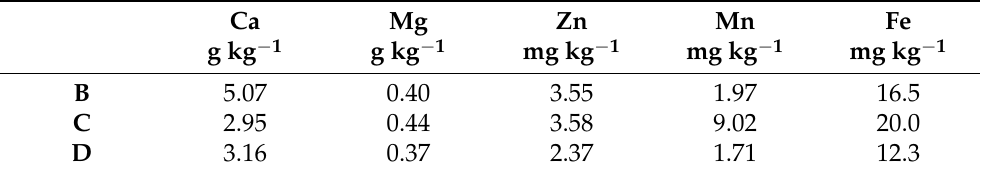
Table 5. Bioavailable content of Ca, Mg, Zn, Mn, and Fe in fresh leaves of Sempervivum tectorum L. as a mean values (RSD for all samples varied between 3–8%).